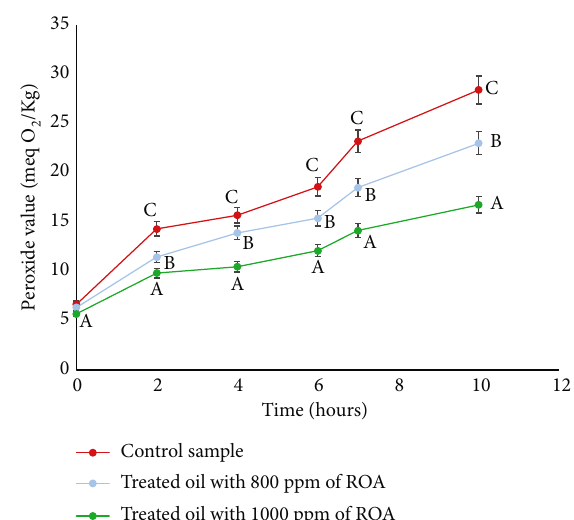
Figure 4: Development of peroxide index during the frying of breaded shrimps in soybean oil. The values followed by di ff erent letters (A, B, and C) are signi fi cantly di ff erent from each other at p <